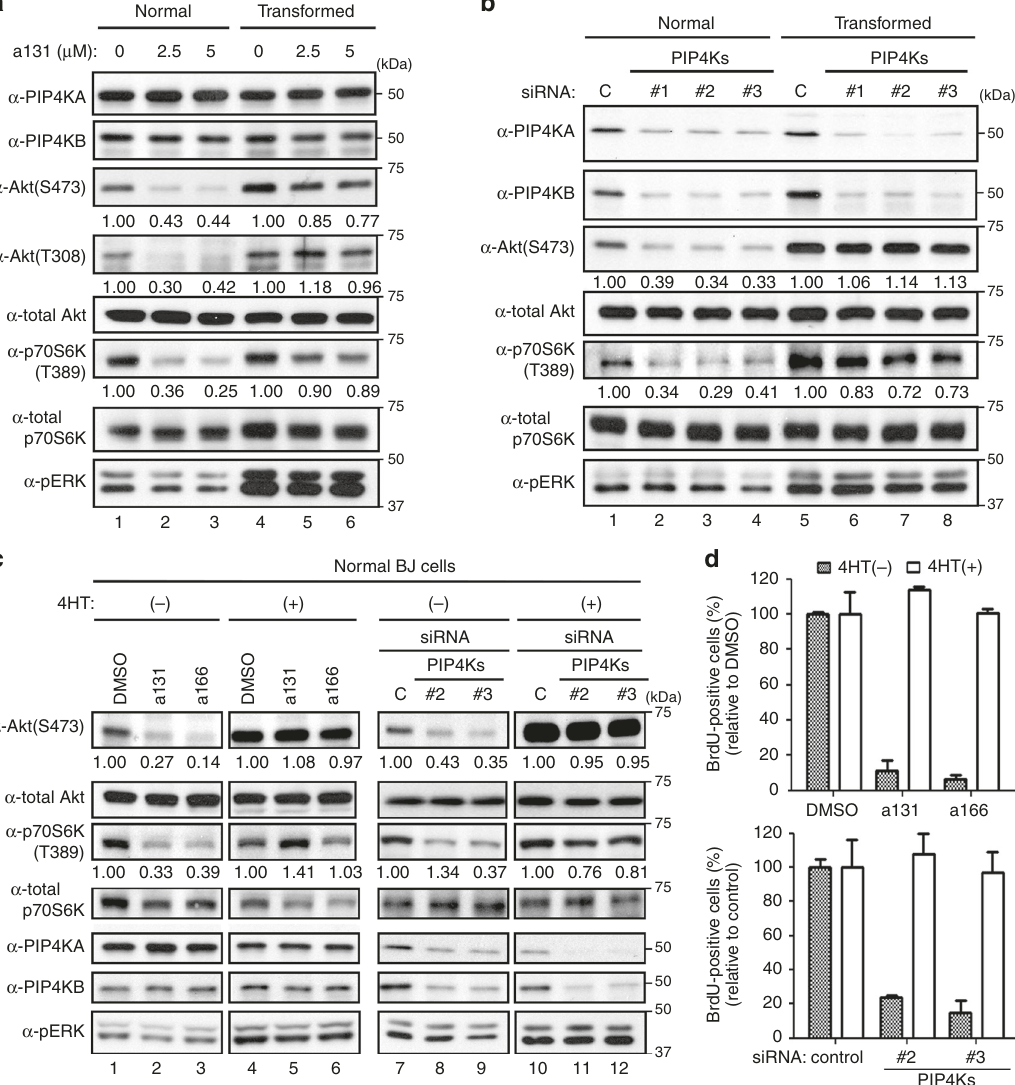
Fig. 3 a131 and Ras antagonistically control the PI3K/Akt/mTOR pathway. a – c Immunoblot analysis of normal and transformed BJ cells treated with a131 or a166 for 24 h a , c or transfected with indicated siRNAs for 48 h b , c . Relative ratios of phosphorylated/total levels of Akt and p70S6K are shown in comparison with DMSO. 4HT(+) indicates normal BJ cells treated with 4-OHT for 24 h to activate H-RasV12-ER. Representative immunoblots shown ( n = 3). d BrdU incorporation assay as in Fig. 1c. 4-OHT [4HT(+)] was added in normal BJ cells for 24 h. Subsequently, cells were treated with a131 or a166 at 5 µ M for 48 h (top). Normal BJ cells were transfected with indicated siRNAs for 48 h and treated with 4-OHT for 24 h (bottom). The percentage of cells with BrdU-positive population in comparison with DMSO is shown with mean values and ± S.D. ( n =